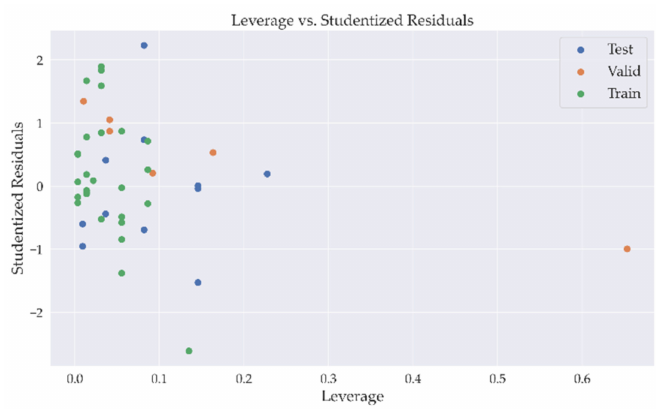
Figure 14. Model_1—Explosive charge mass–leverage vs.